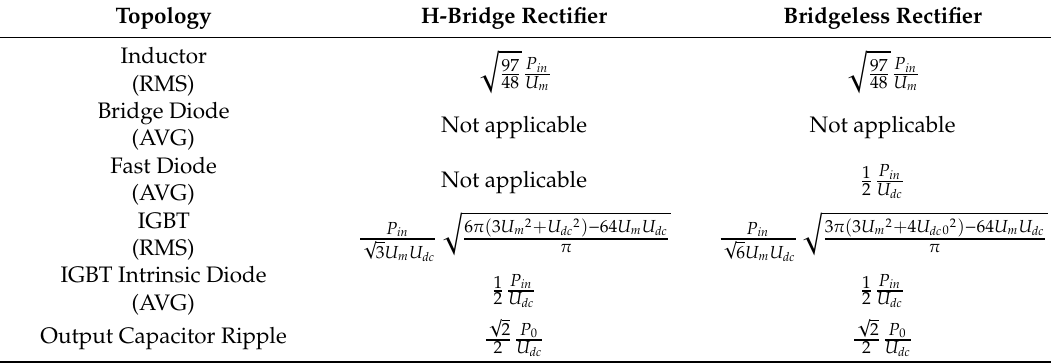
Table 4. The component current stress of H-bridge rectifier and bridgeless rectifier.